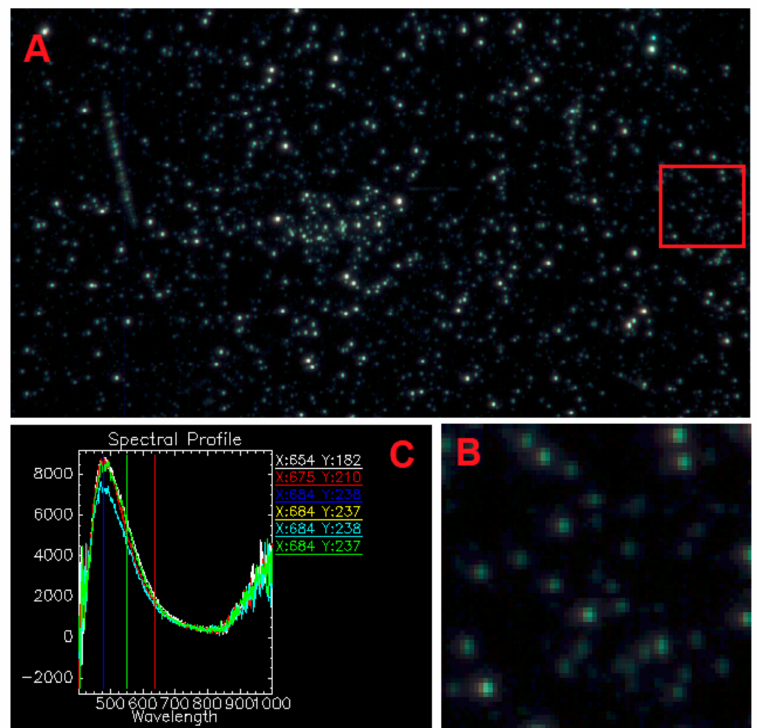
Figure 3. Image recorded by enhanced dark-field microscopy using Cytoviva ( A ); magnification of marked area from figure A corrected with the lamp spectrum ( B ) and spectra collected in the isolated points ( C